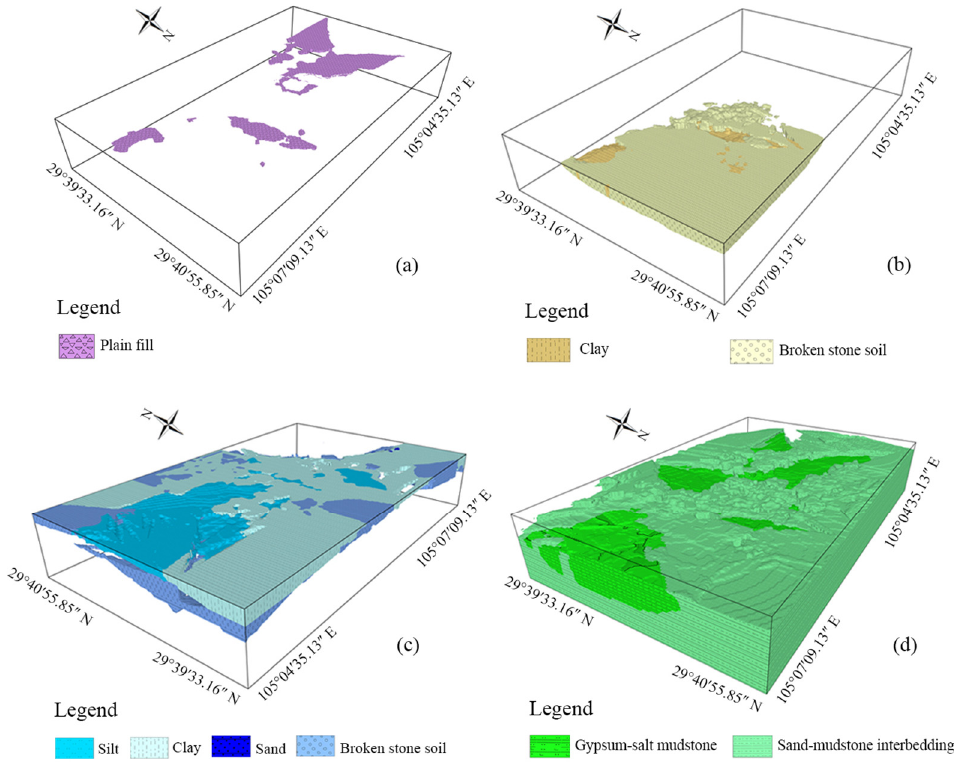
Figure 5. The lithologic 3D map of different stratum in the geological model. ( a ) Qh ml ; ( b ) Qh apl ; ( c ) Qp 3 -Qhz; ( d ) K 2 g.